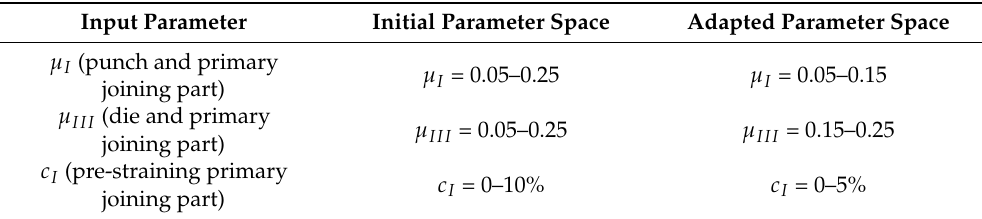
Table 3. Overview of the initial and adapted parameter spaces for the robustness